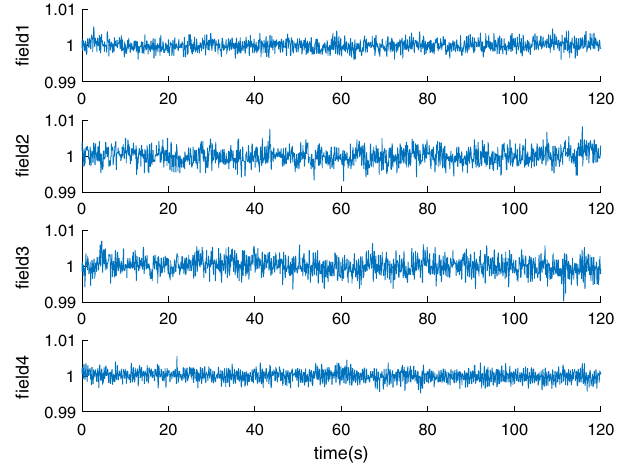
FIG. 12. Electric field pick-up signal in the four SCDTL modules versus